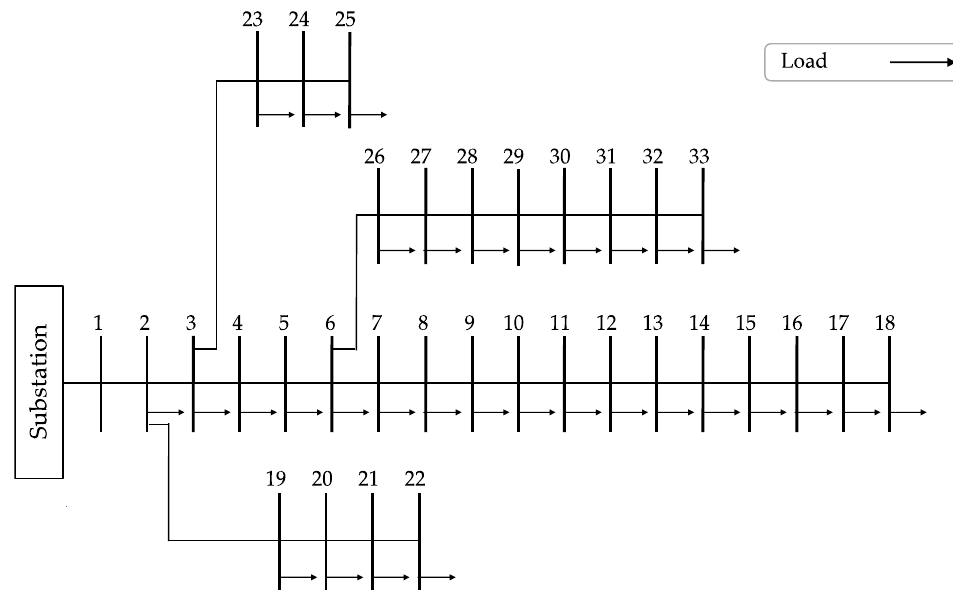
Figure 2. IEEE-33 bus distribution test system.